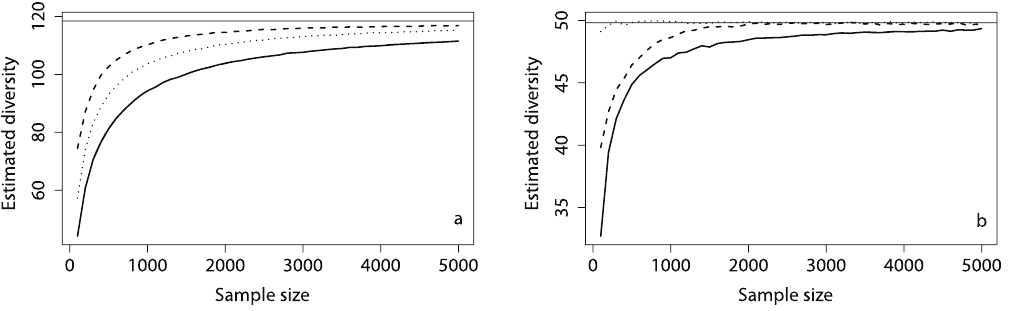
Figure 2. Efficiency of bias correction. Estimation of diversity of the BCI tropical forest plot for two values of the order of diversity q (a: 0.5, b: 1.5). The horizontal line is the actual value calculated from the whole data (around 25000 trees, species frequencies are close to a log-normal distribution). Estimated values are plotted against the sample size (100 to 5000 trees). Solid line: naive estimator with no correction; dotted line: Grassberger correction; dashed line: Chao and Shen’s correction. For q=0.5, Chao and Shen perform best. For q=1.5, Grassberger’s correction is very efficient even with very small samples.